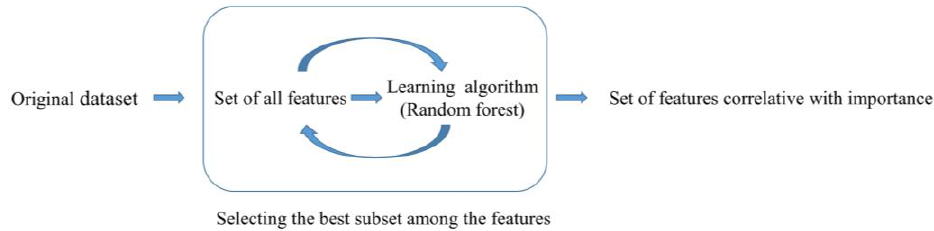
Figure 1. Schematic representation of recursive feature elimination (RFE) in random forest algo- rithm.